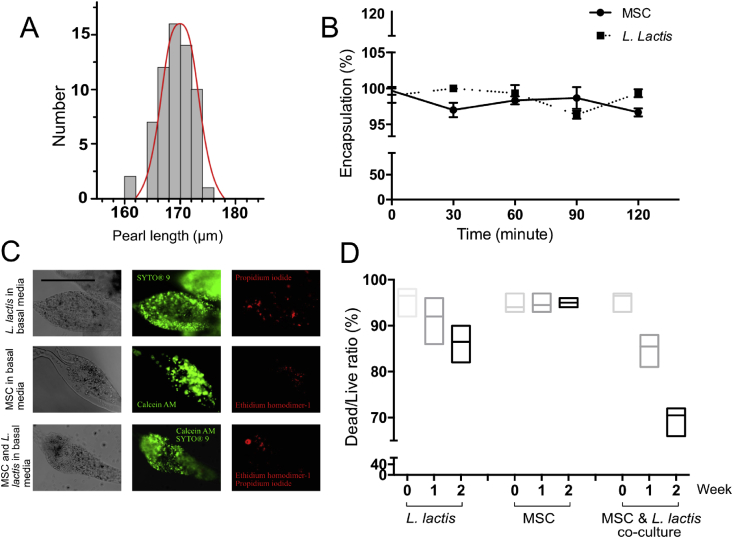
Monodispersity, encapsulation, and viability of microbeads. (A) Pearl size (long axis) distribution of produced hydrogel of two miscible fluid streams under laminar flow conditions using flow rates of 500 ​μL ​h−1 for the two inner phases and 5000 ​μL ​h−1 for the outer phase. The mean length of the formed pearl was 167 ​μm with an RSD of 3.2%. Scale bar: 100 ​μm. (B) Cell (MSCs and L. lactis) encapsulation efficiency. The cell counts at each time point are the result of 8 measurements sequentially acquired at 30-min intervals at room temperature for 2 ​h. (C) Fluorescent images of two-week-old alginate hydrogels with L. lactis and MSCs. The hydrogel was stained with BacLight Bacterial Viability Kit for L. lactis and Viability/Cytotoxicity Kit, for MSCs. Both kits stain viable cells in green (SYTO® 9 and Calcein AM) and non-viable cells in red (Propidium iodide and Ethidium homodimer-1), a 50:50 mixture of the kits were used for coculture. N > 5-10 microgels were analyzed for each condition. Scale bar: 100 ​μm. (D) The viability graph of L. lactis, MSCs, and coculture. MSCs, mesenchymal stem cells.